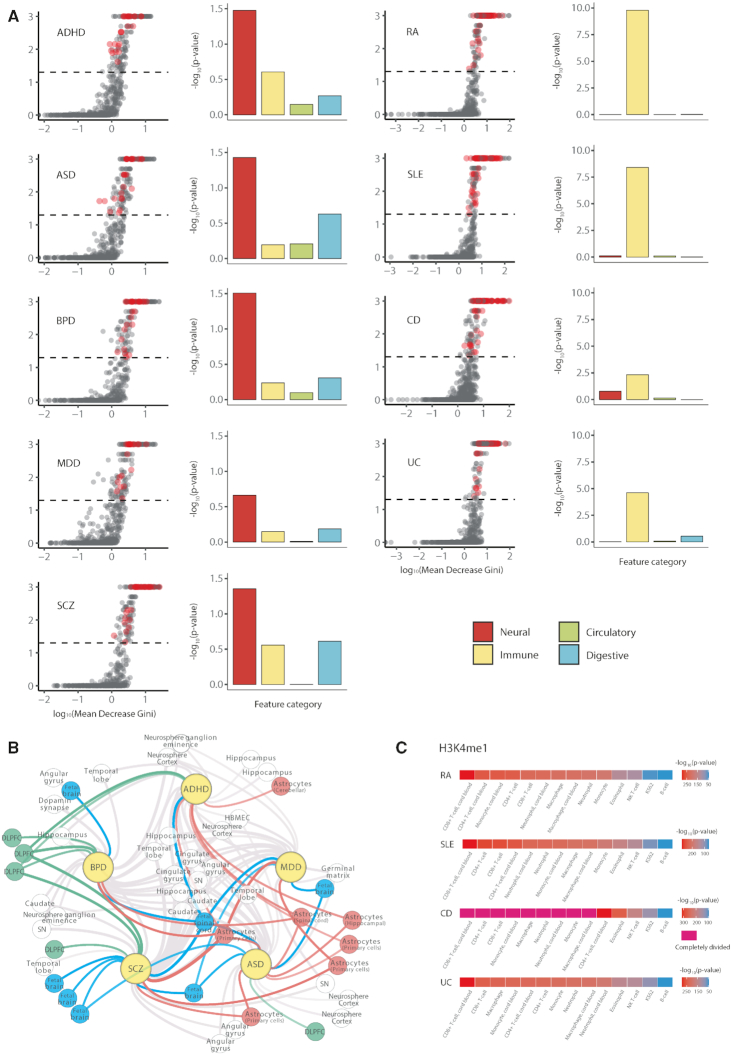
Pathophysiological relevance of prediction outcomes. (A) Results of feature importance analysis. The MDG score (x-axis) and its P value (y-axis) for individual features with significant (P < 0.05) disease related features highlighted in red (left panel). Enrichment of the significant features in different categories (neural, immune, circulatory, or digestive) as estimated by the hypergeometric test (right panel). (B) Network of neural features that were important in each disease model. The small nodes represent neural features that showed a significant (P < 0.05) MDG in the prediction model of the connected disease. The significant neural features, including those related to fetal brain (blue), astrocytes (red), and dorsolateral prefrontal cortex (green), were mapped to the relevant disorder (yellow). (C) Enrichment of positive calls for autoimmune diseases for the BLUEPRINT epigenome data for various immune cell types. Positive calls are more enriched in the regulatory regions of lymphocyte lineages rather than granulocytes. Shown here are regulatory regions marked by H3K4me1. The H3K27ac data is provided in Supplementary Figure S5.